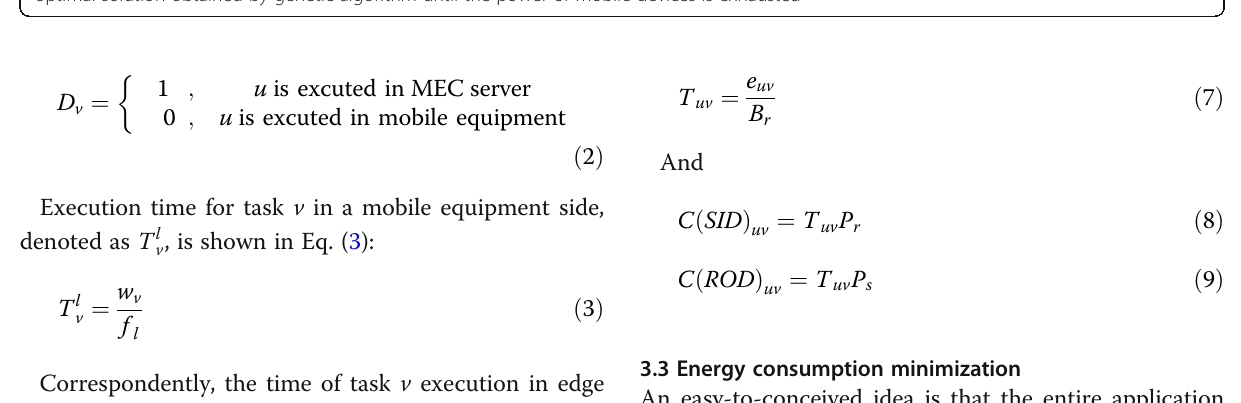
Fig. 8 Comparison of residual electricity trend between FGMBGA and optimization FGMBGA. As can be seen from the figure, when the residual power of mobile devices is reduced to a certain value, the optimization algorithm will no longer consume the battery energy of mobile devices, and the residual power tends to be flat, while the unmodified algorithm will continue to execute tasks on mobile devices according to the optimal solution obtained by genetic algorithm until the power of mobile devices is